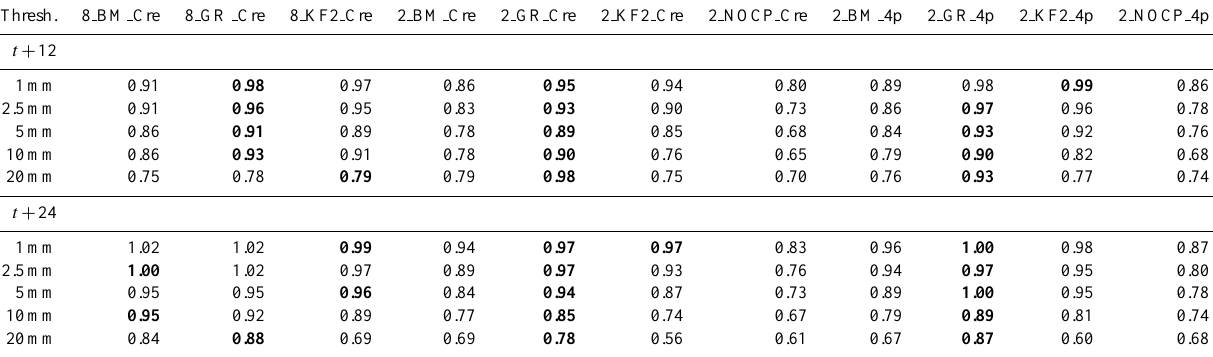
Table 9. As in Table 2 but for bias score and three different CPSs: Betts-Miller, Grell and Kain-Fritsch-2 (and also for NOCP in the 2km grid).